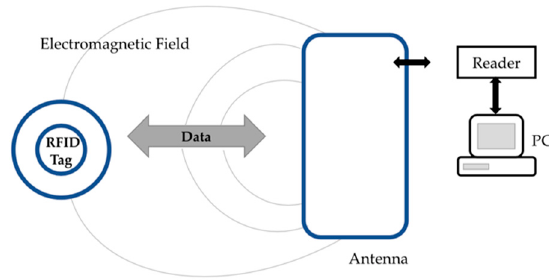
Figure 5. The working principle of radio frequency identification (RFID) tag, adapted from [28].